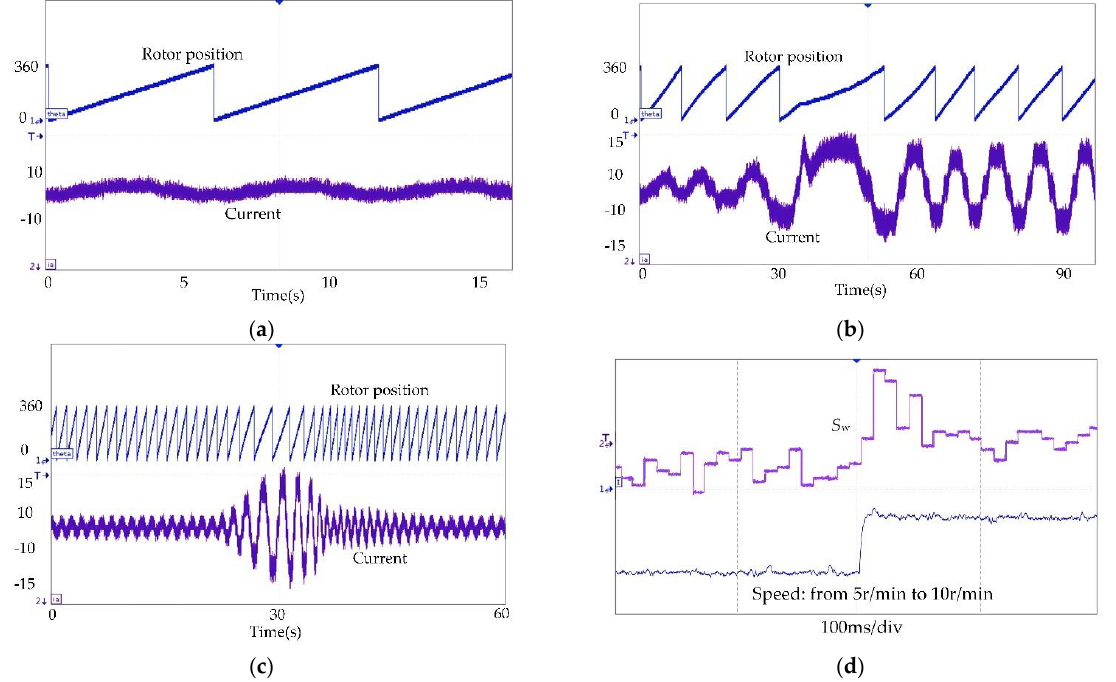
Figure 21. Hardware experimental results: ( a ) Rotor position and stator current at low speed; ( b ) Rotor position and stator current during sudden loading; ( c ) Rotor position and stator current during load disturbance; ( d ) Variation of the controller selection switching frequency when speed